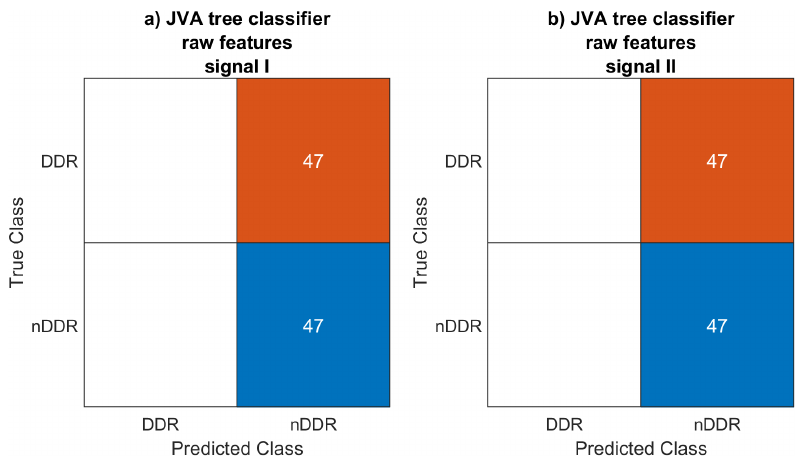
Figure A7. Confusion matrices for raw features used in the JVA decision tree classifier for the ( a ) first and ( b ) second signals.